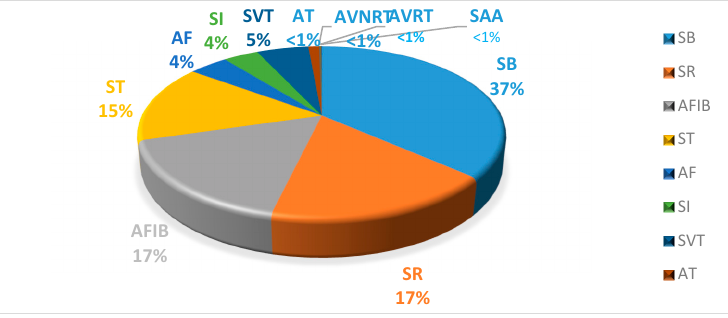
Figure 1. The distribution rate graph of rhythm classes across all records.